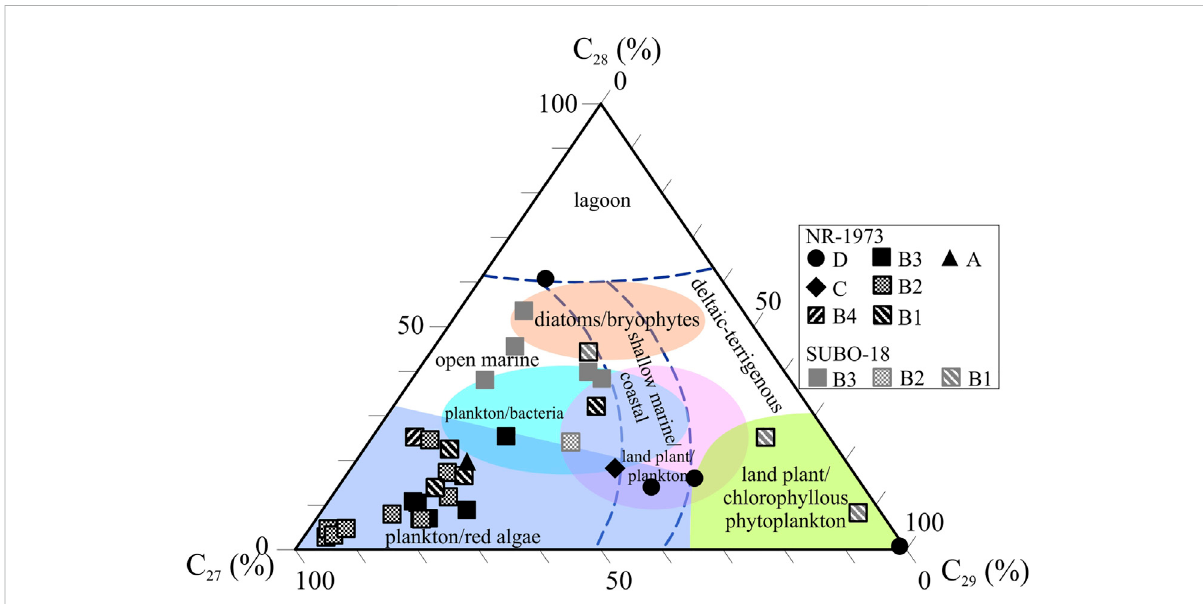
FIGURE 8 Triangle plot of regular C 27 -, C 28 - and C 29 -steranes (%) normalized to the sum of all regular steranes for the post-impact sediments in the Nördlinger Ries (Modi fi ed after Huang and Meinschein, 1979; Volkman, 1986; Kodner et al., 2008). See Figure 2 for stratigraphic